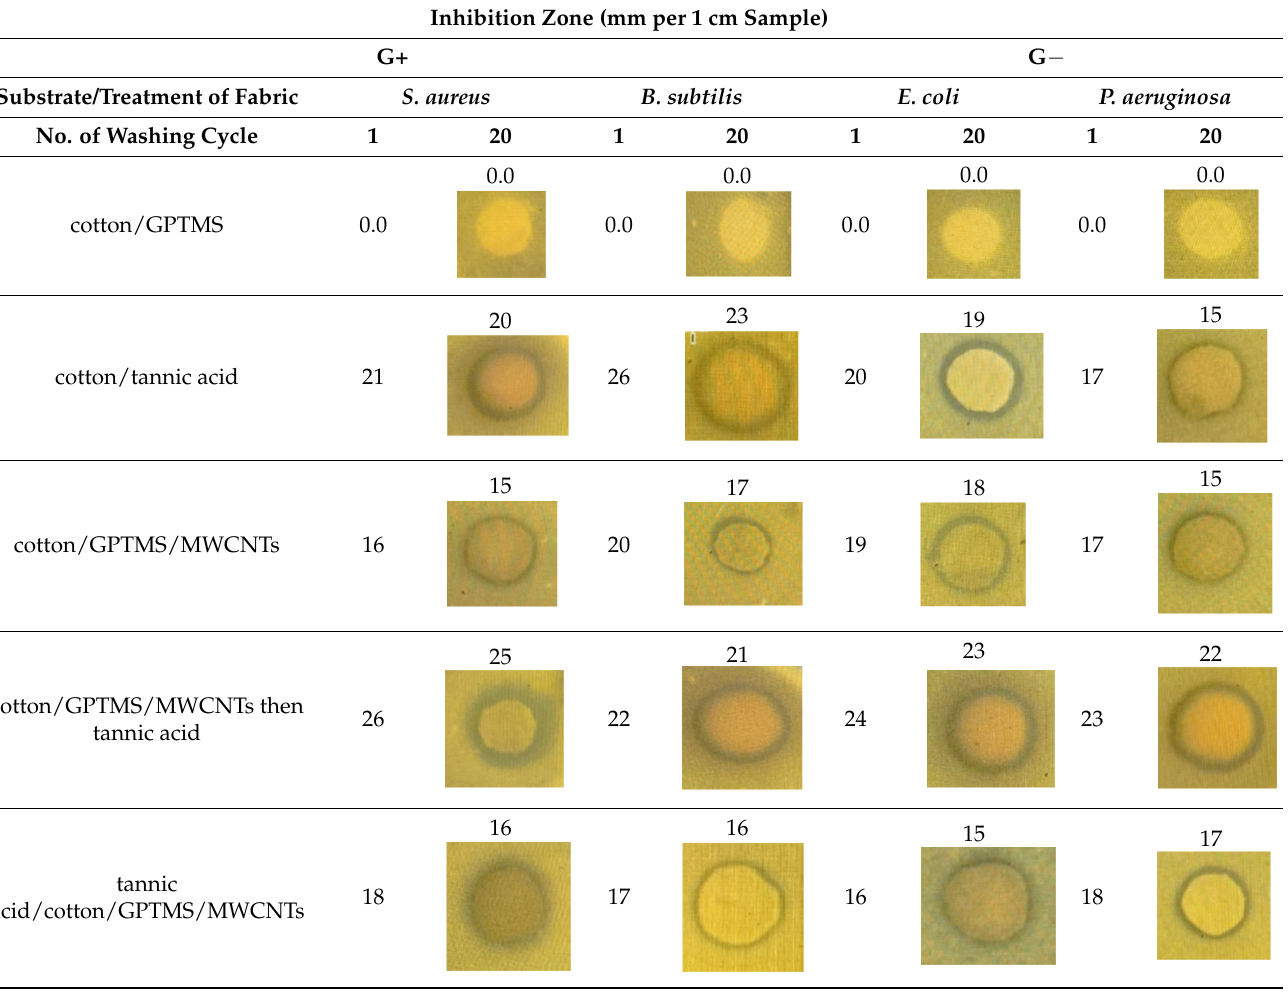
Table 2. UPF values of cotton fabrics treated under different conditions.